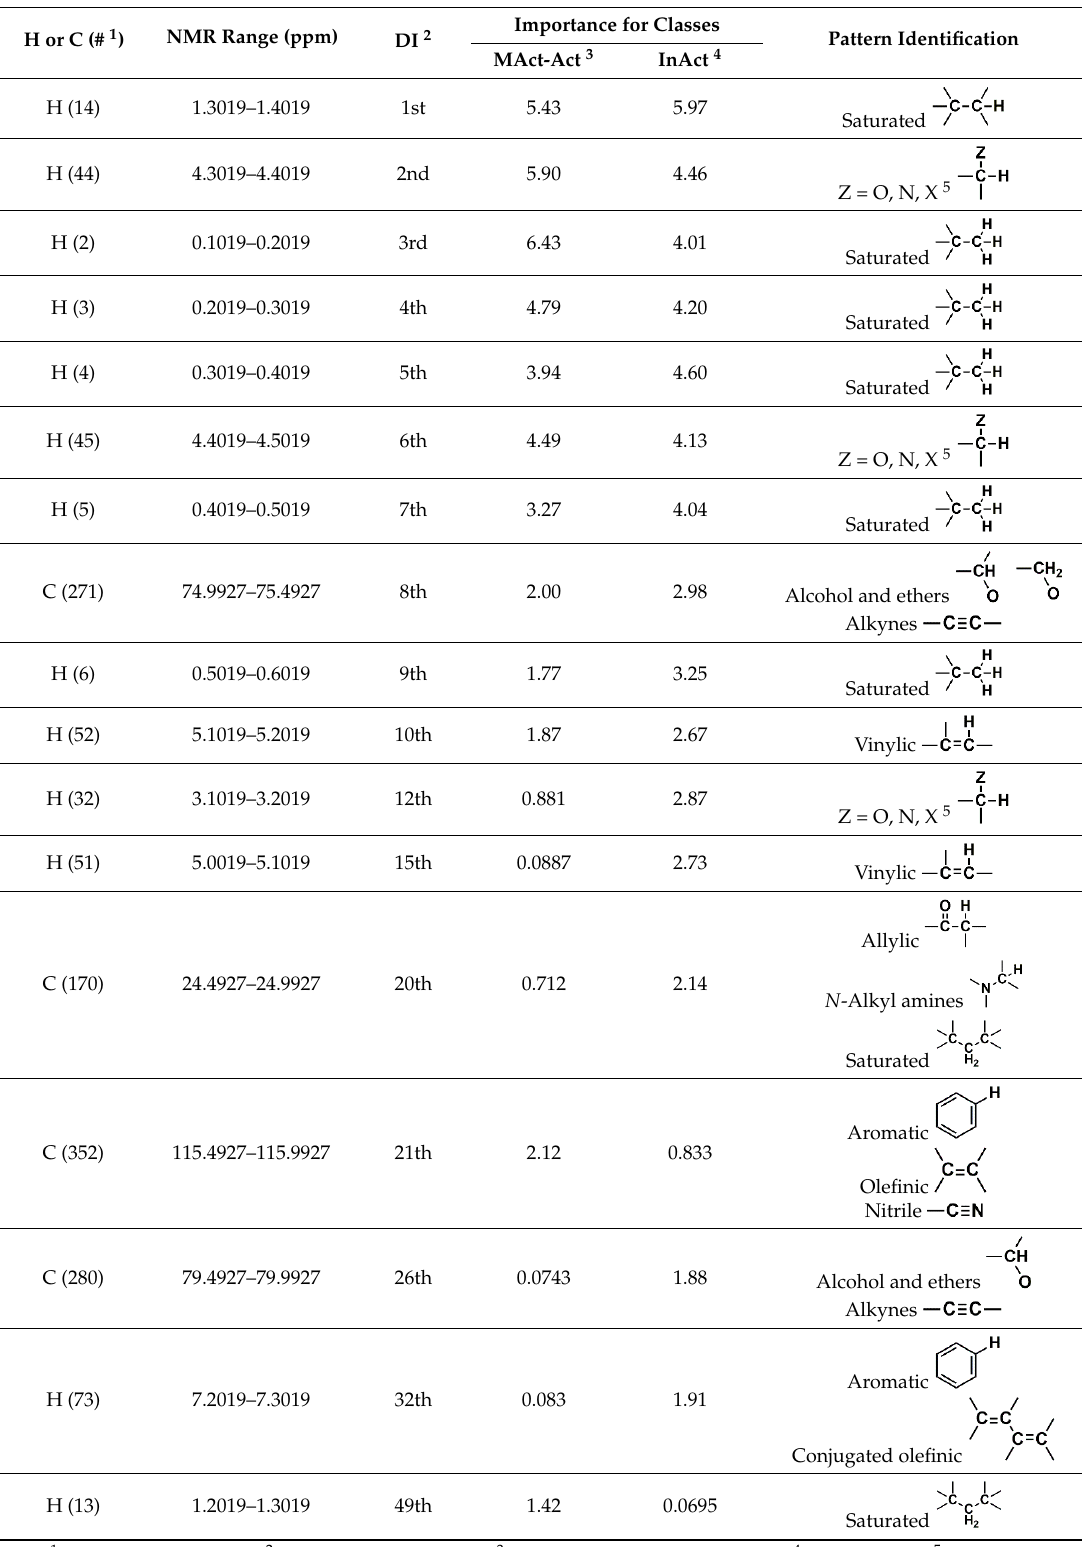
Table 10. Analysis of NMR Descriptors for modeling HCT116 activity in the best RF model. H or C (# 1 ) NMR Range (ppm) DI 2